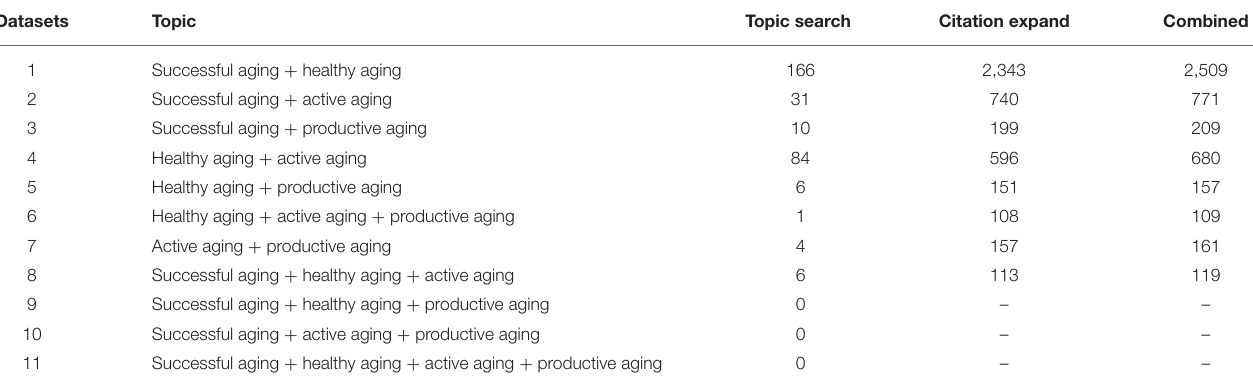
TABLE 1 | The combined search of four aging